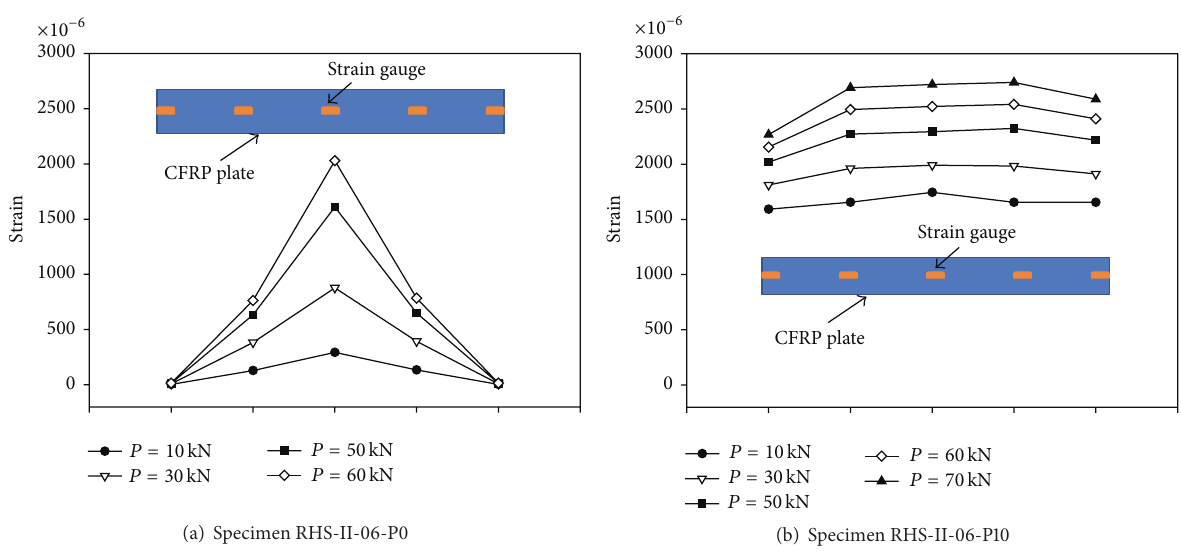
Figure 9: Comparison of strain distribution on CFRP